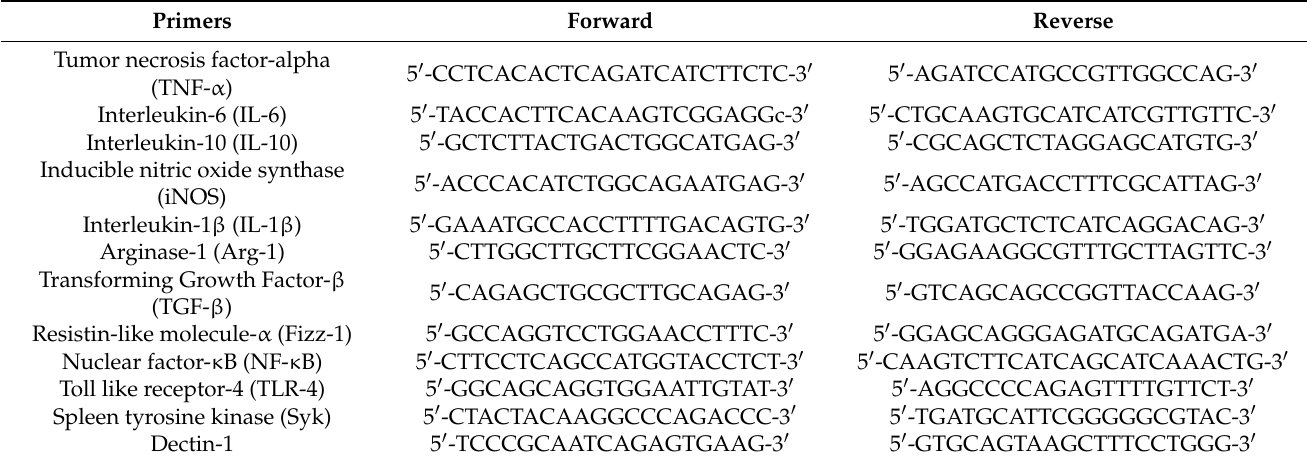
Table 1. List of primers used in the